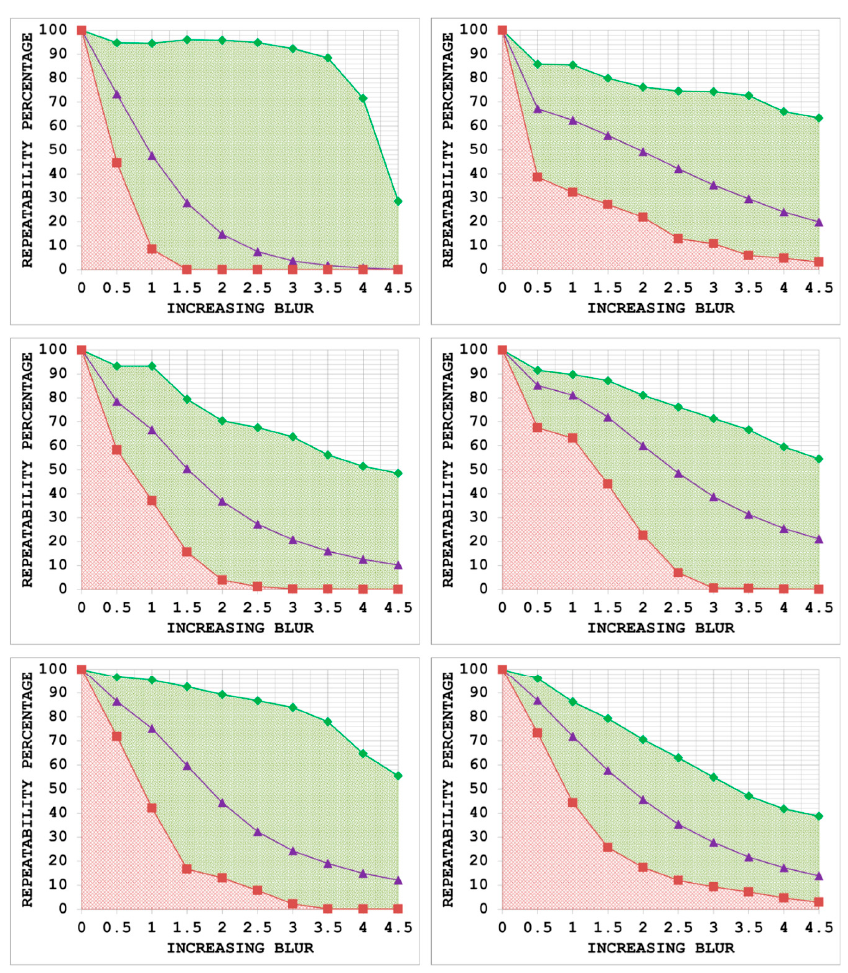
Figure 5. Results for blur changes utilizing the proposed framework and the image database for MSER ( top left ), IBR ( top right ), Harris-Laplace ( center left ), Hessian-Laplace ( center right ), SURF ( bottom left ) and SFOP ( bottom right ) detectors.